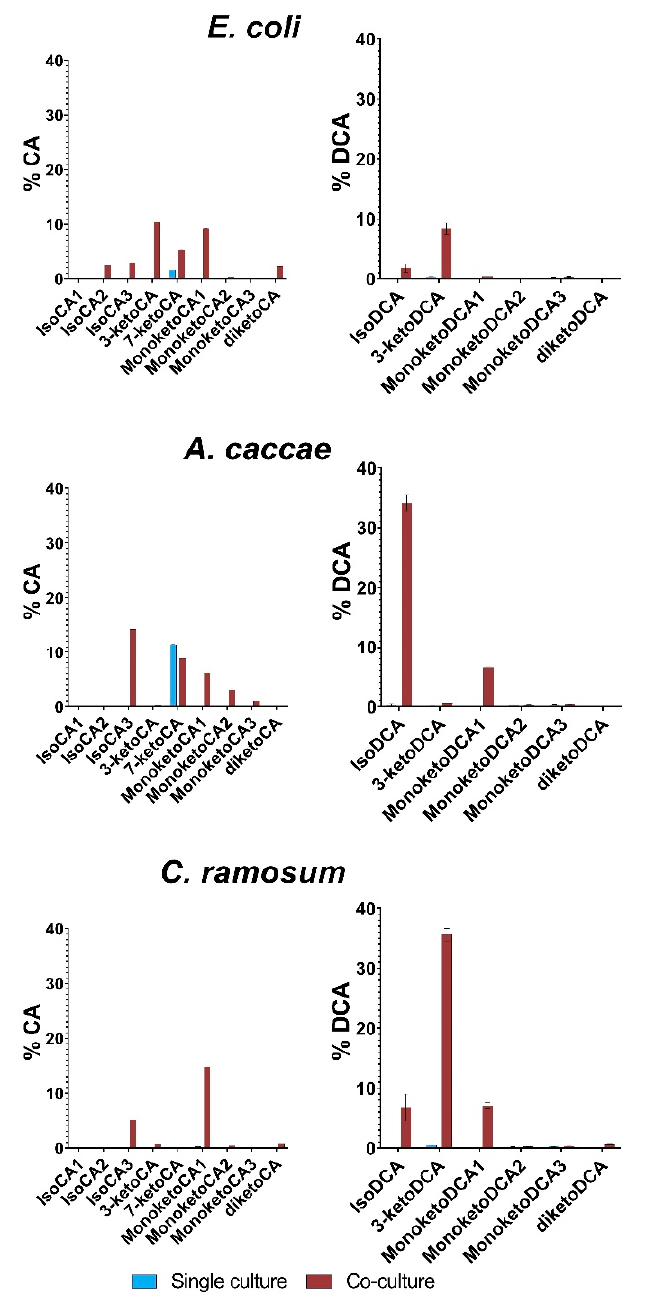
Figure 7. Epimerization and oxidization of CA and DCA in single and co-cultures. The bars represent the mean of three biological replicates and the abundances are ratios compared to the peaks of the original added bile acids due to lack of standard for the different iso and keto forms. Blue is single culture and red is co-culture.